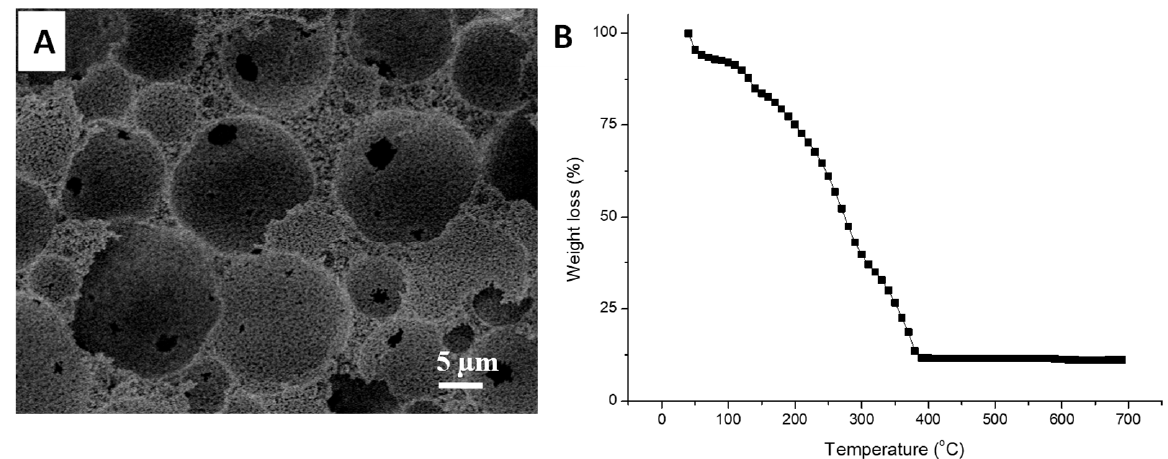
Figure A3. ( A ) The SEM image of silver–PAM composite with 60 v / v % internal phase volume, and ( B ) the TGA profile of the composite monolith.